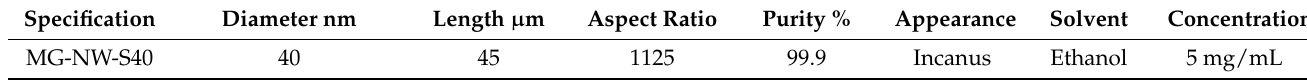
Table 1. Main parameters of silver nanowires